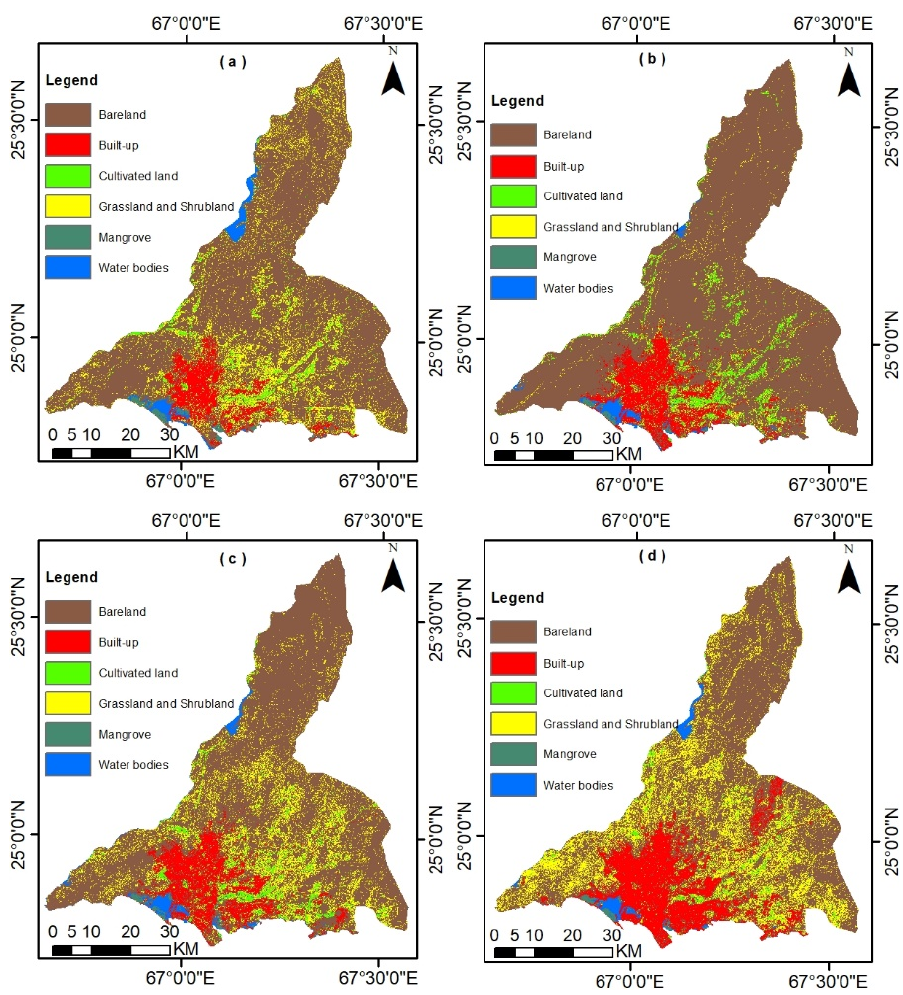
Figure 4. LULC map of Karachi in ( a ) 1990, ( b ) 2000, ( c ) 2010, and ( d ) 2020.